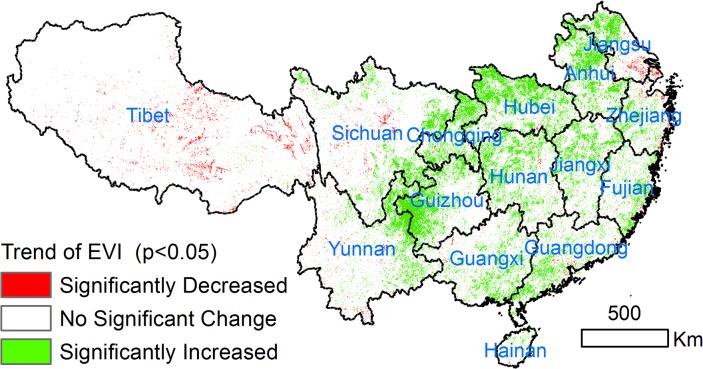
The significant changes in EVI for the period of 2000–2009 (p<0.05).